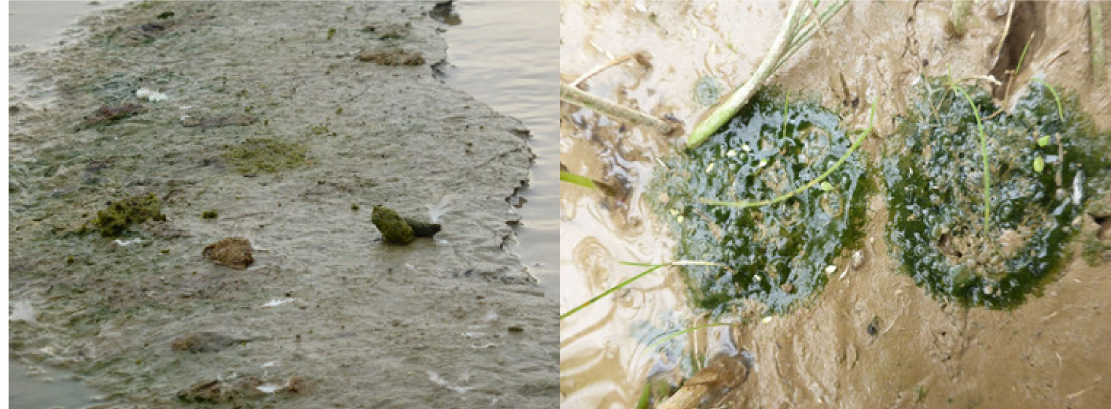
Figure A2. Algae colonies around the bird feces on the clay material, first stage of succession and example of habitat modification.